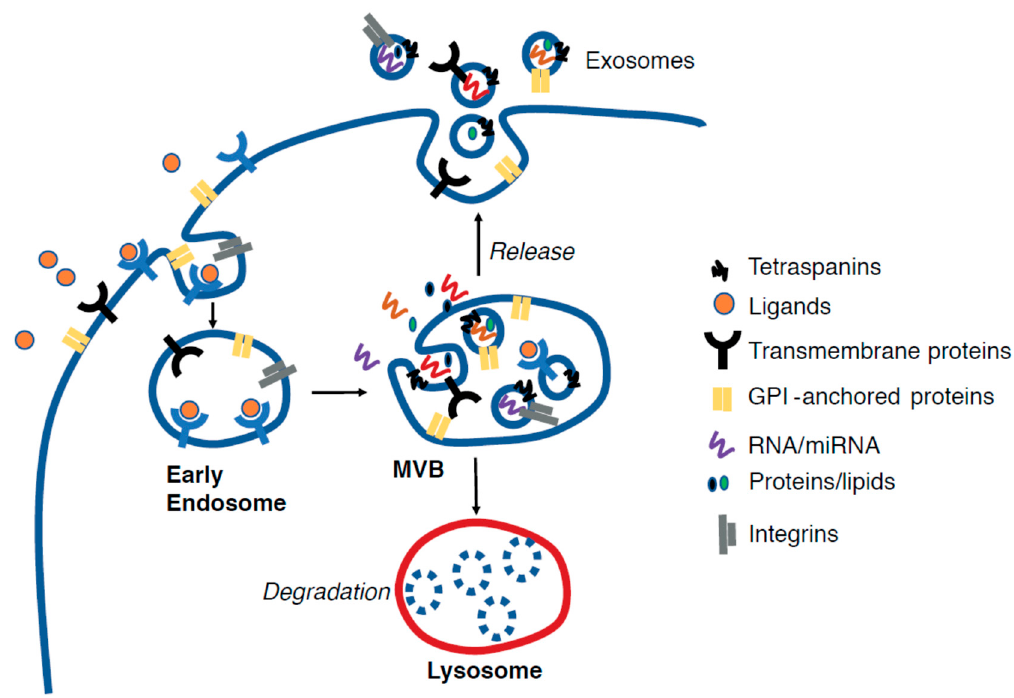
Figure 2. Schematic representation of exosomes biogenesis. The in-budding of endosomes originates the multivesicular bodies (MVBs) which can follow different fates: (i) fusion with the lysosome, which leads to degradation of MVB content; (ii) fusion with the cell membrane and release of intraluminal vesicles to the extracellular space, thus generating exosomes. The exosomes are enriched with several proteins located on the membrane including, but not limited to, transmembrane proteins/receptors, integrins, glycophosphatidylinositol (GPI)-anchored proteins, and tetraspanins, which are specific markers of exosomes. Intra-exosomal proteins, nucleic acids (coding and non-coding RNA), lipids, and other metabolites, do also exist, and are loaded during the invagination of MVB membranes. Such molecules can be transferred to host cells once exosomes are released by donor cells and activate signaling pathways.